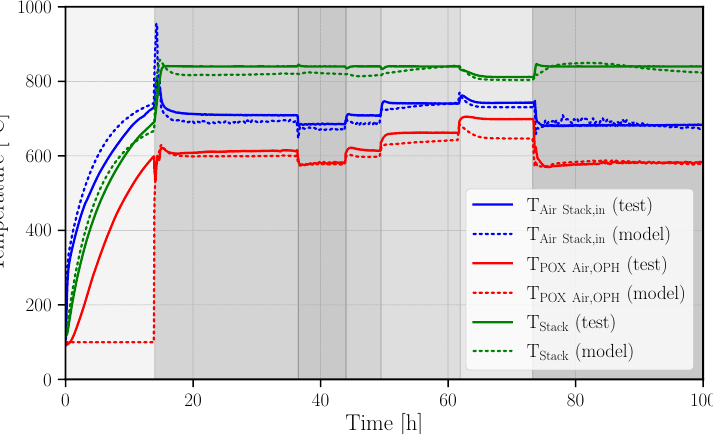
Figure 13. Modeled and measured temperatures of the hotbox, OPH air outlet, stack air inlet and stack air outlet temperature during start-up and load changes from 1000, 1150, 1000, 800, 600 and 1150 W el .